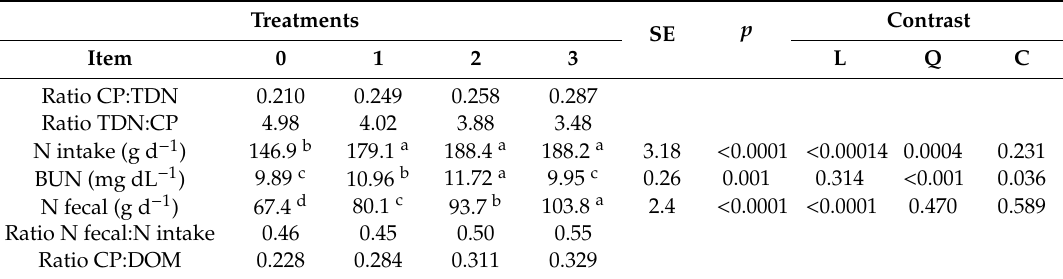
Table 6. Indicators of the flow of nitrogen consumed by heifers fed Leucaena leucocephala .